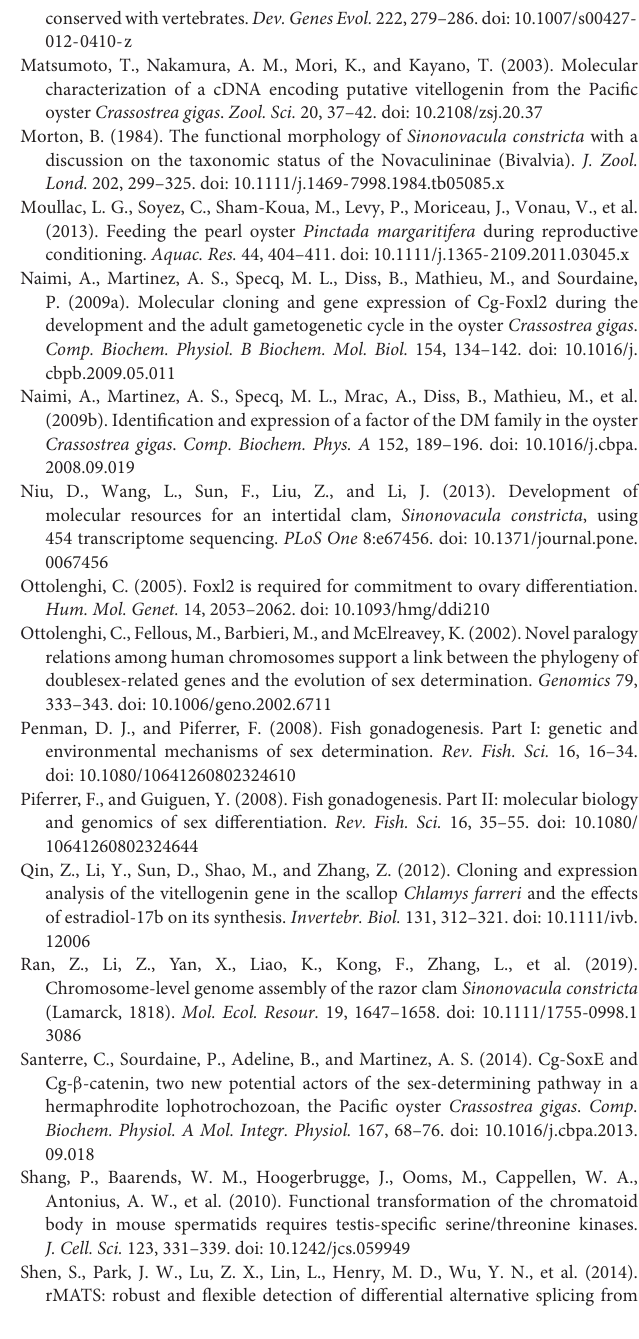
Supplementary Table 1 | Forty-five sex-related genes identified in S. constricta . Supplementary Table 2 | The information sequences used in this